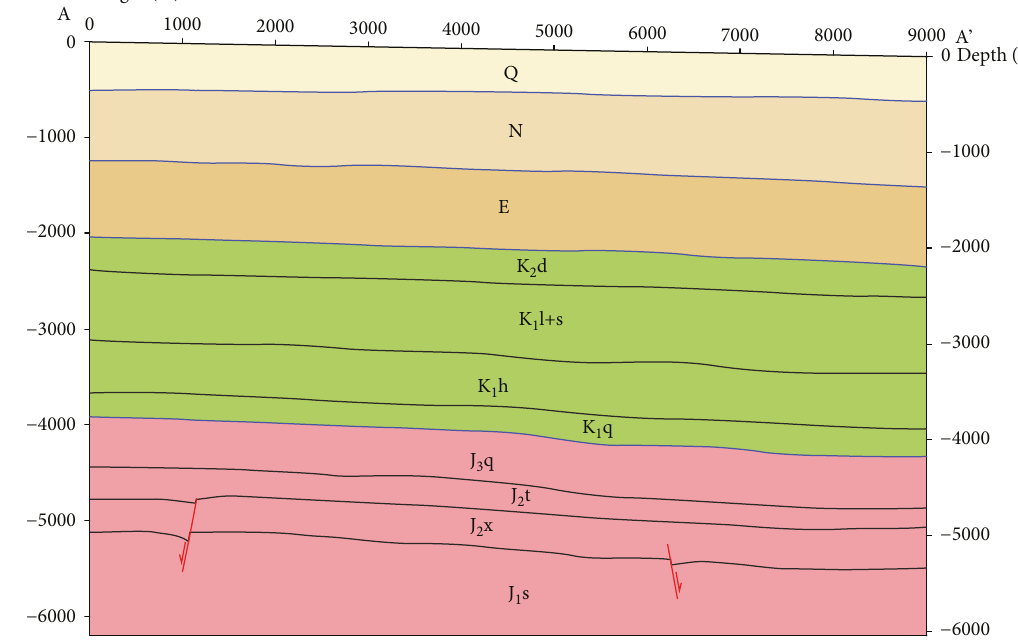
Figure 2: Geological pro fi le near the target injection well (see the location of the pro fi le in Figure